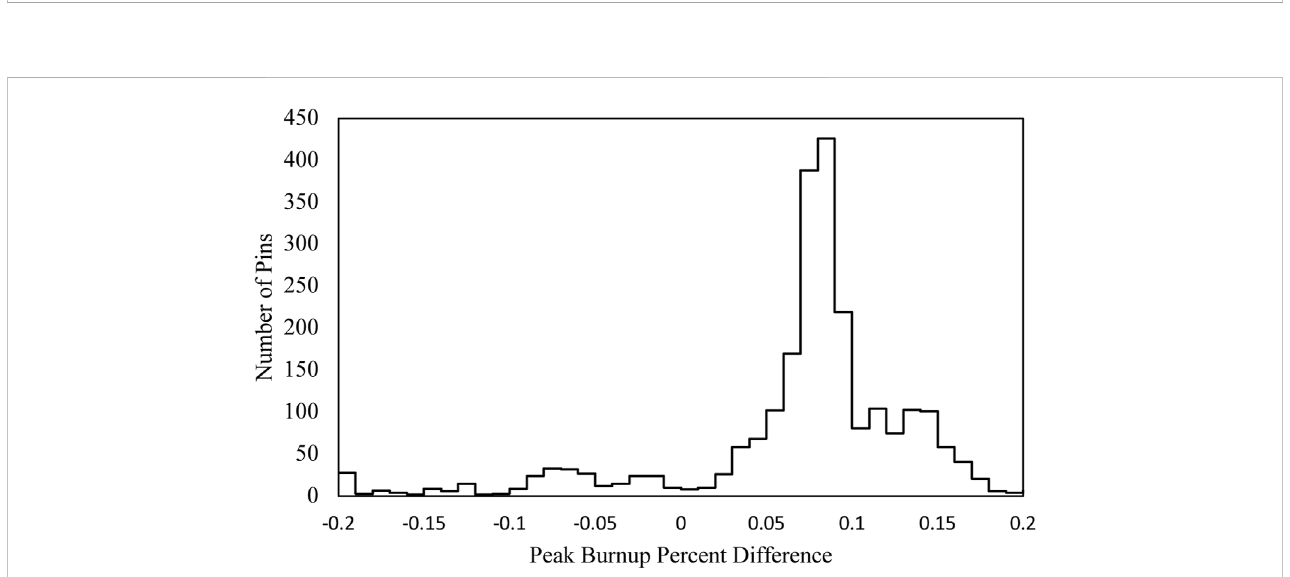
Difference in peak burnup between BISON and Fuels Irradiation and Physics Database (BISON subtracted from